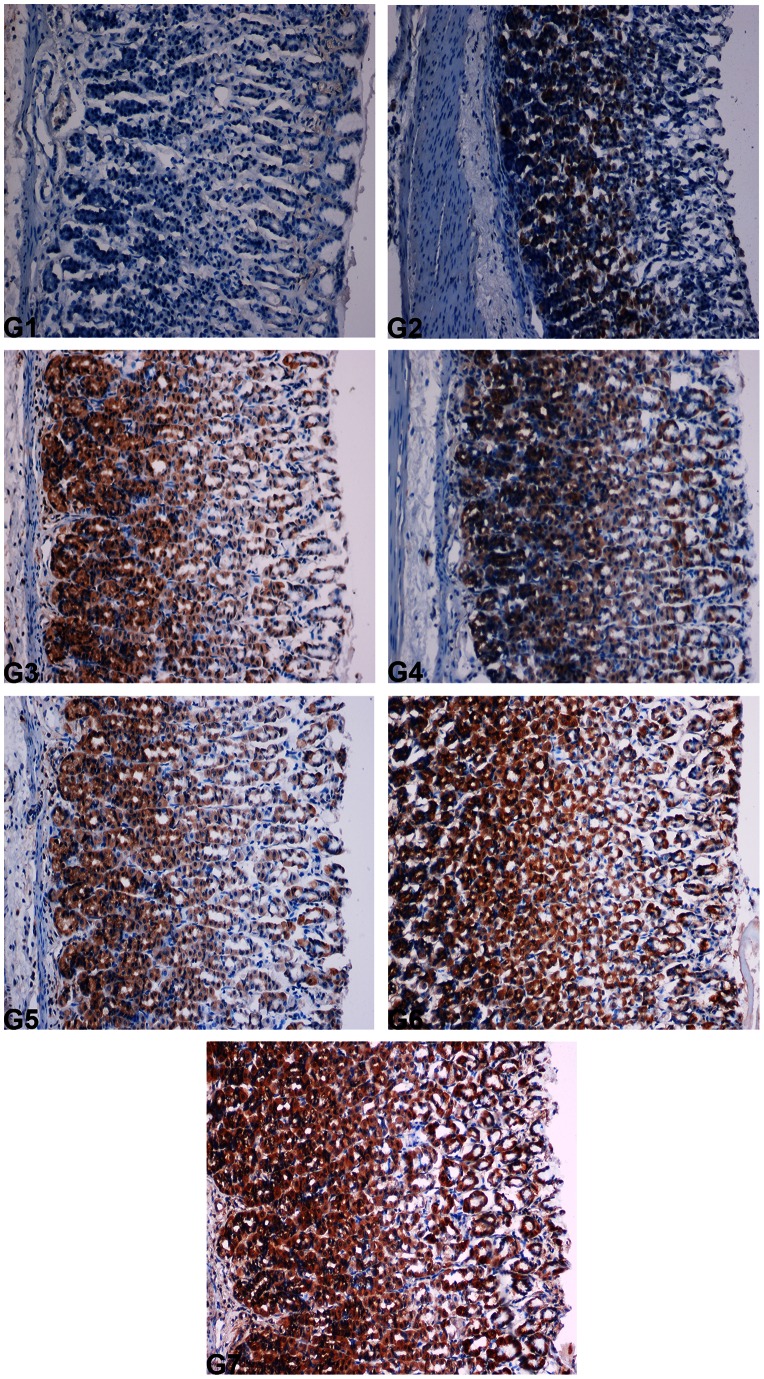
Immunohistochemical analysis of HSP70 expression in the gastric mucosa of rats.(G1) (Normal control group); (G2) (Ulcer control group); (G3) (Omeprazole); (G4) (50 mg/kg), (G5) (100 mg/kg), (G6) (200 mg/kg), (G7) (400 mg/kg) Parkia speciosa extract. HSP70 protein expression was upregulated in rats pretreated with Parkia speciosa (magnification 20×).